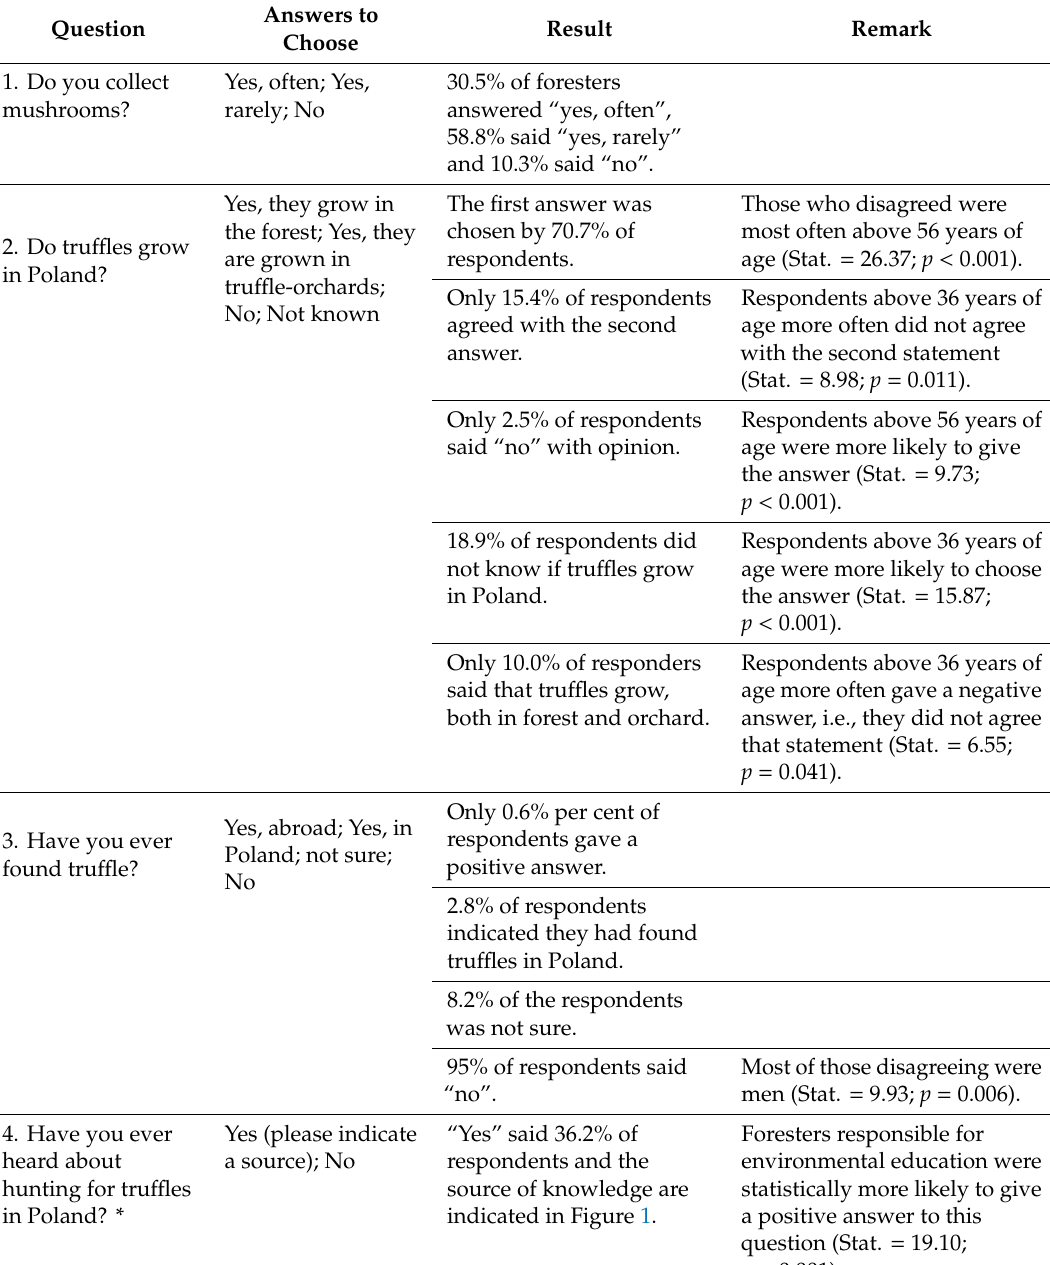
Table 5. Respondents’ answers with comments based on statistical analysis. The symbol “*”indicates that the respondent were asked to provide an